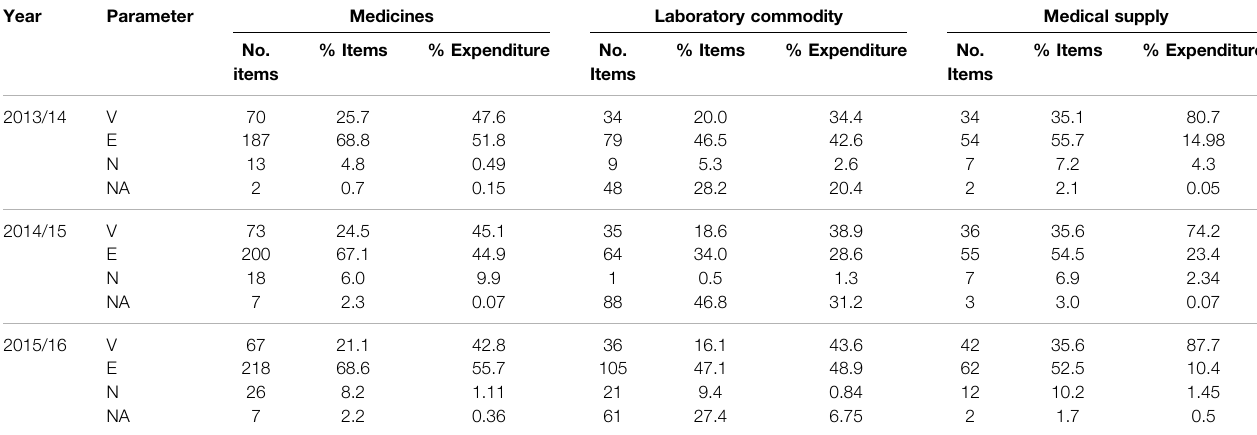
TABLE 2 | VEN analysis of medicines at SPHMMC for 2013/14 –